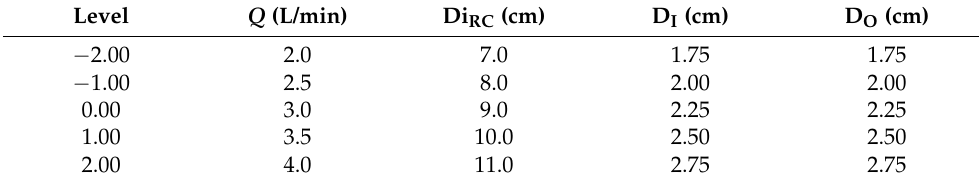
Table 4. Matrix of levels used in the factorial design for the upper inlet and outlet